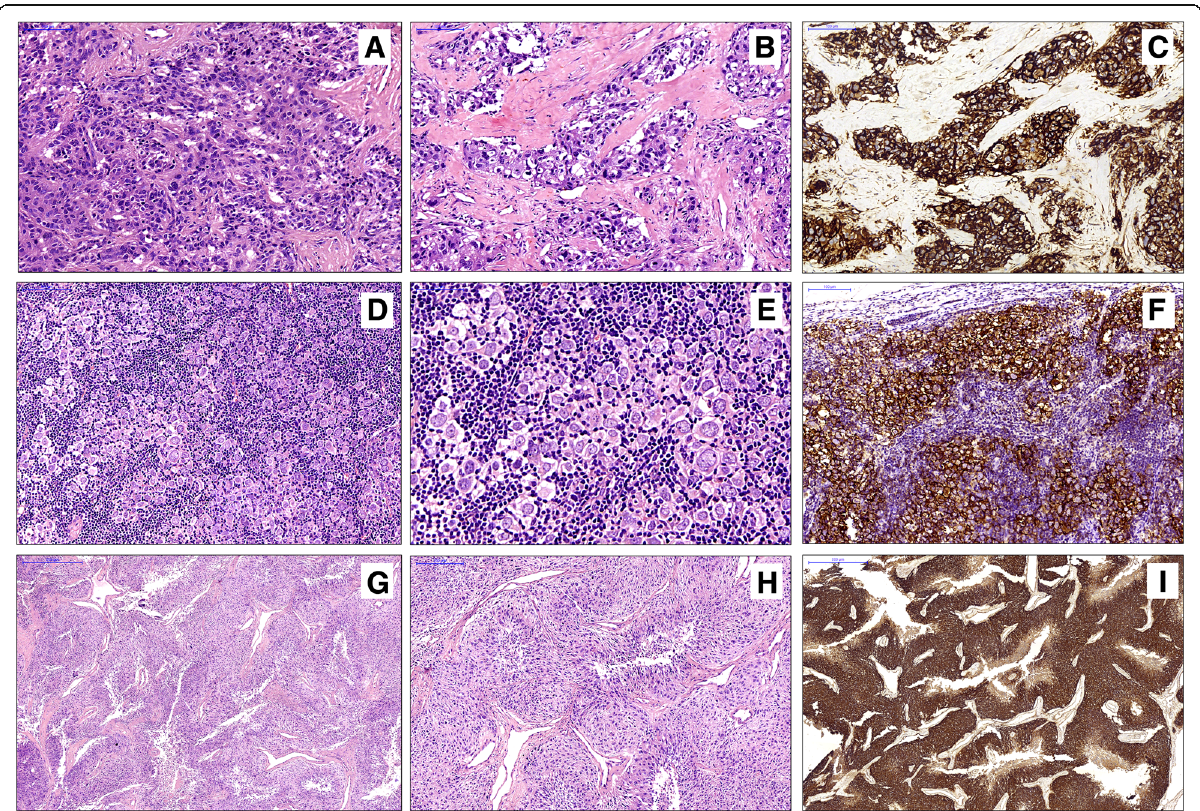
Fig. 4 a - c : The area resembles desmoplastic infiltrative carcinoma. Atypical epithelioid tumor cells arranged in nested or pseudo-glandular structures ( a ) infiltrate the hyperplastic collagen fibers ( b ), which are positive for CD23 ( c ). d - f : The area resembles anaplastic large cell lymphoma. Atypical large tumor cells with a nested or patchy pattern fill the lymphatic sinuses ( d ). On high power, the tumor cells are round or polygonal with marked atypia ( e ) and are positive for CD21 ( f ). g - i : The area mimics hemangiopericytoma. Short spindle-shaped tumor cells are arranged radially around many fissure-like or dendritic thin-walled blood vessels ( g ) with only a few infiltrating lymphocytes ( h ), which are positive for CD23 ( i